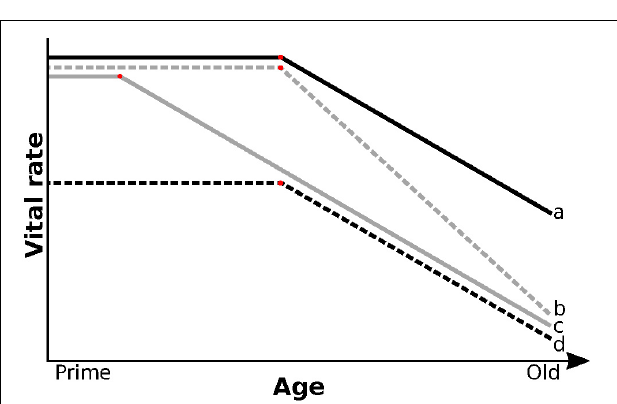
FIGURE 4 | Poor environmental conditions during early life could have different effects on late-life performance. Solid black line (a) illustrates individuals born in good environment. When faced with challenging early life, senescence may show a higher rate (gray dashed: b) or an earlier onset (gray solid, c). Harsh early-life environment may also lower performance independently of age (black dashed; d). In wild populations, patterns of age specific change in performance may be a combination of the